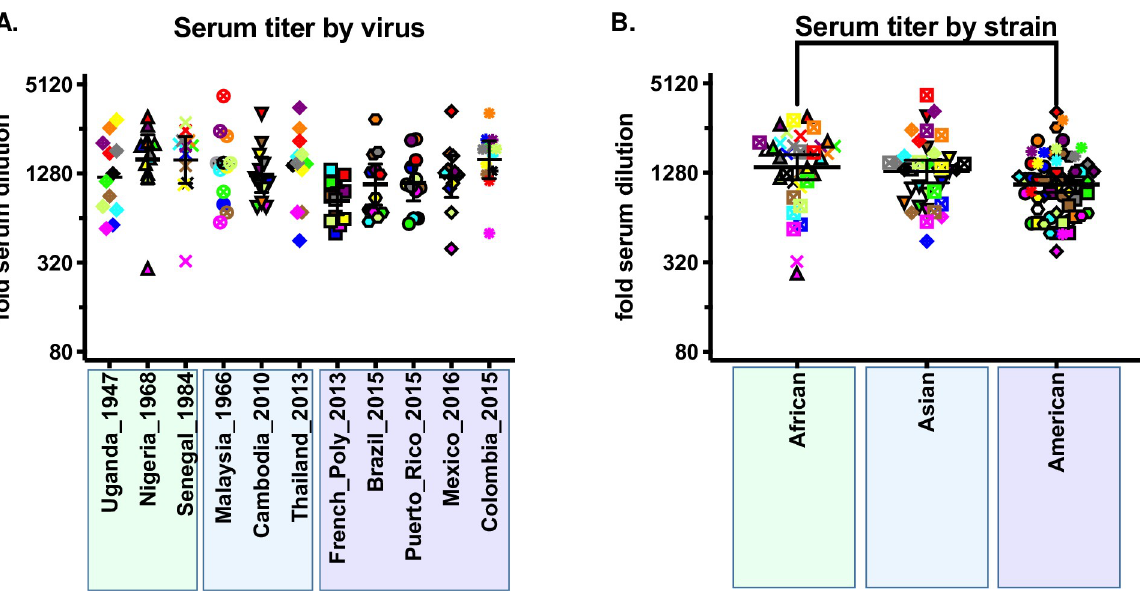
Fig 4. Neutralization by virus and strain. A) FRNT 50 titers for each serum against each virus. The Y-axis shows fold-serum dilution, the X-axis shows each virus, the phylogenetic tree below the X-axis shows the relative genetic relatedness of the viruses. Individual virus symbols are indicated below the figure and the symbols are color-coded to match the sera in Fig 2. B) FRNT 50 titers for ZIKV grouped by strain. Strain pairs found to be different by ANOVA followed by Tukey HSD correction for multiple comparisons are show by brackets (P = 0.038).